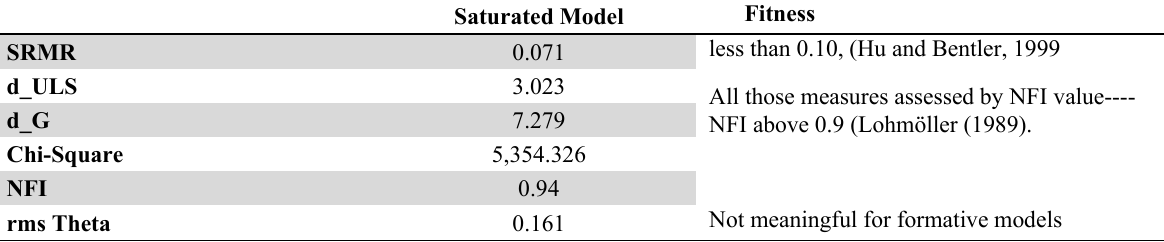
Fig. 3. R Square measurement e-service quality –relationship quality research model Results Summary for (E-Service, Relationship Quality )Model